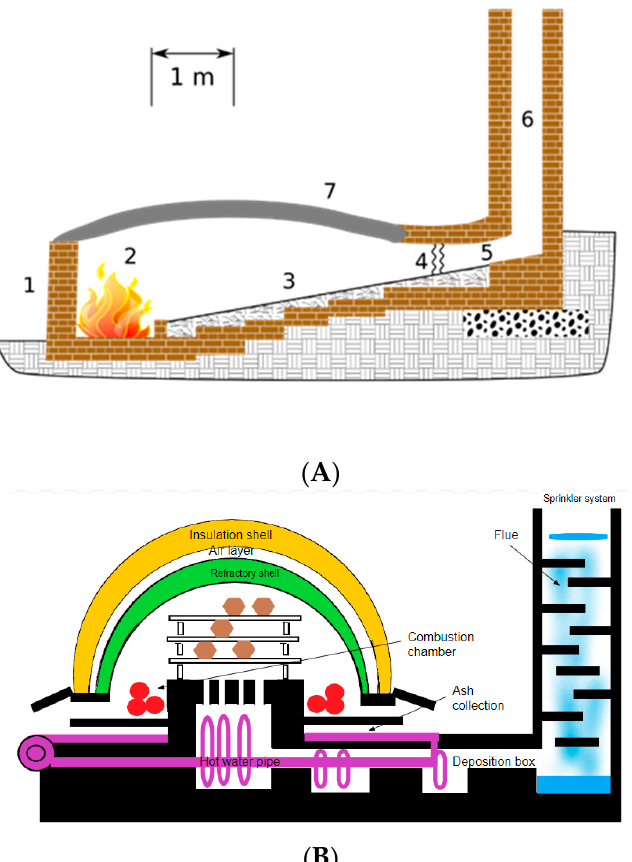
Figure 1. Kiln redesign (Tzu-Chieh Lee, 2021) [23]. ( A ) Old style wood-fired kiln. ( B ) Waste wood- fired kiln. 1: Door about 75 cm wide 2: Firebox. 3: Stacking floor made of silica sand. The unfired pots are placed here. 4: Dampers, two-one for firing, the second to tightly shut the flue. 5: Flue. 6: Chimney 3 m high. 7: Cast arch, made of heat resistant cement (castable). (Anagama kiln, 2005) [24]. Dioxin control with a combustion reheating decomposition